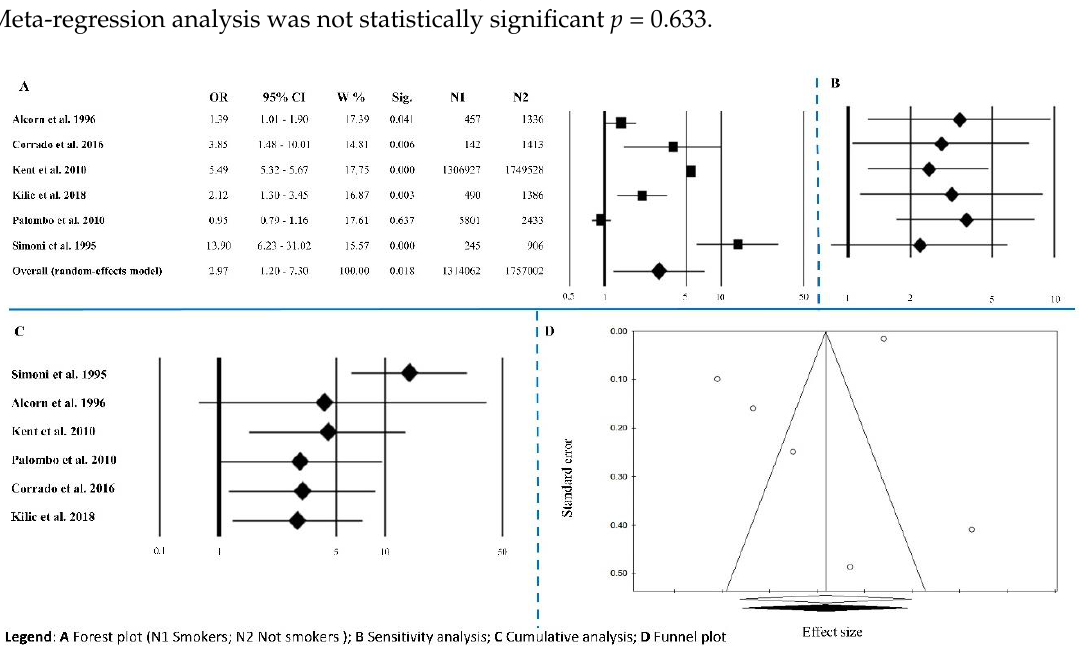
Figure 3. Smoker. ( A ) Forest plot (N1 Smokers; N2 Not smokers); ( B ) sensitivity analysis; ( C ) cumulative analysis; ( D ) funnel